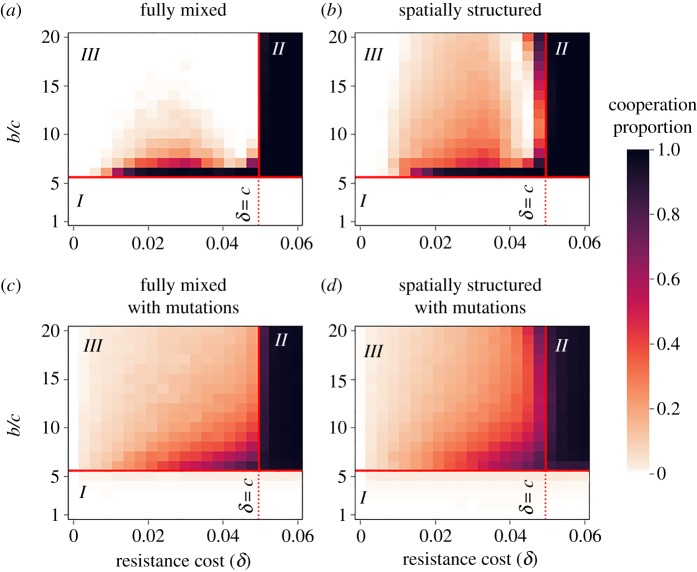
Mutations and spatial structure help maintain cooperation in the face of host resistance in finite populations. The proportion of cooperators after up to 5000 generations is plotted as a function of the b/c ratio on the y-axis and δ on the x-axis. The colour of each square represents the average of 200 stochastic simulation runs. Panels (a,c) show the results of fully mixed populations, while panels (b,d) show the results of spatially structured populations. Panels (a,b) show the results without mutations, while panels (c,d) show the results with mutation rates of μ = 10−4 in all directions (α ↔ β and S ↔ R). Consistent with the analytic results, we find that cooperation goes extinct if (2.1) is not maintained, and cooperation fixates if (2.1) is satisfied and δ > c. Both mutations and spatial structure significantly widen the parameter range allowing the maintenance of cooperation in polymorphism. Simulation parameters: Tβ = 0.25, Tα = 0.9Tβ, c = 0.05. All simulations used one interaction per generation, perfect vertical transmission of both alleles and microbes, and were initialized with equal proportions of the four host types. The results were robust to different mutation rates of μ = 10−3 and μ = 10−5 (electronic supplementary material, figure S6). The presented intermediate averages in area III usually represent population polymorphisms, apart from panel (a) (electronic supplementary material, figure S7). Stopping criteria is detailed in electronic supplementary material, S4.1. The results were robust to an alternative stopping threshold of 10 000 generations (electronic supplementary material, figure S8).